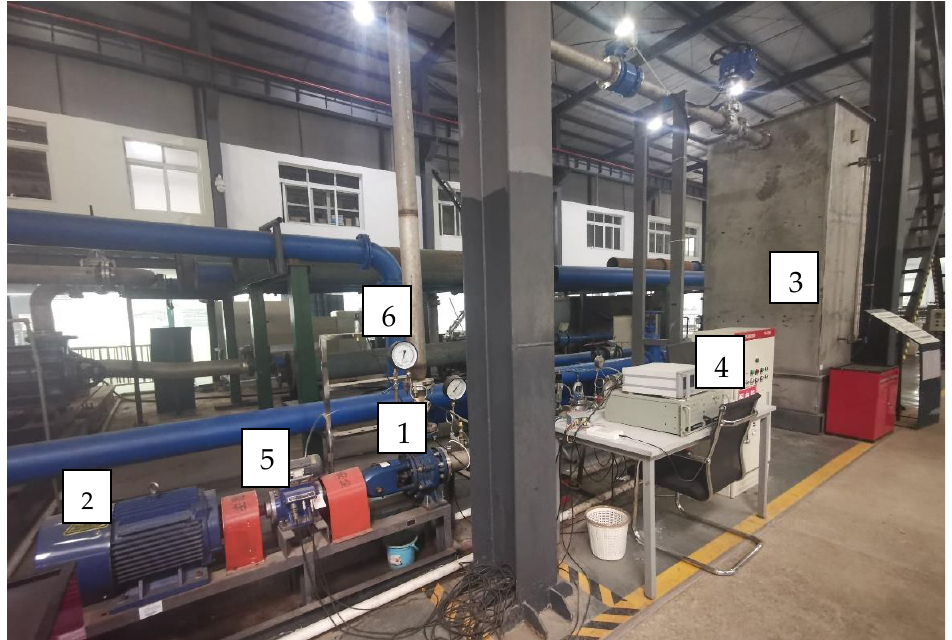
Figure 5. Open cycle test stand for blade disc pump performance measurements. 1 — Disc pump; 2 — variable frequency motor; 3 — water tank; 4 — power control unit; 5 — torque sensor; 6 — pressure sensor.